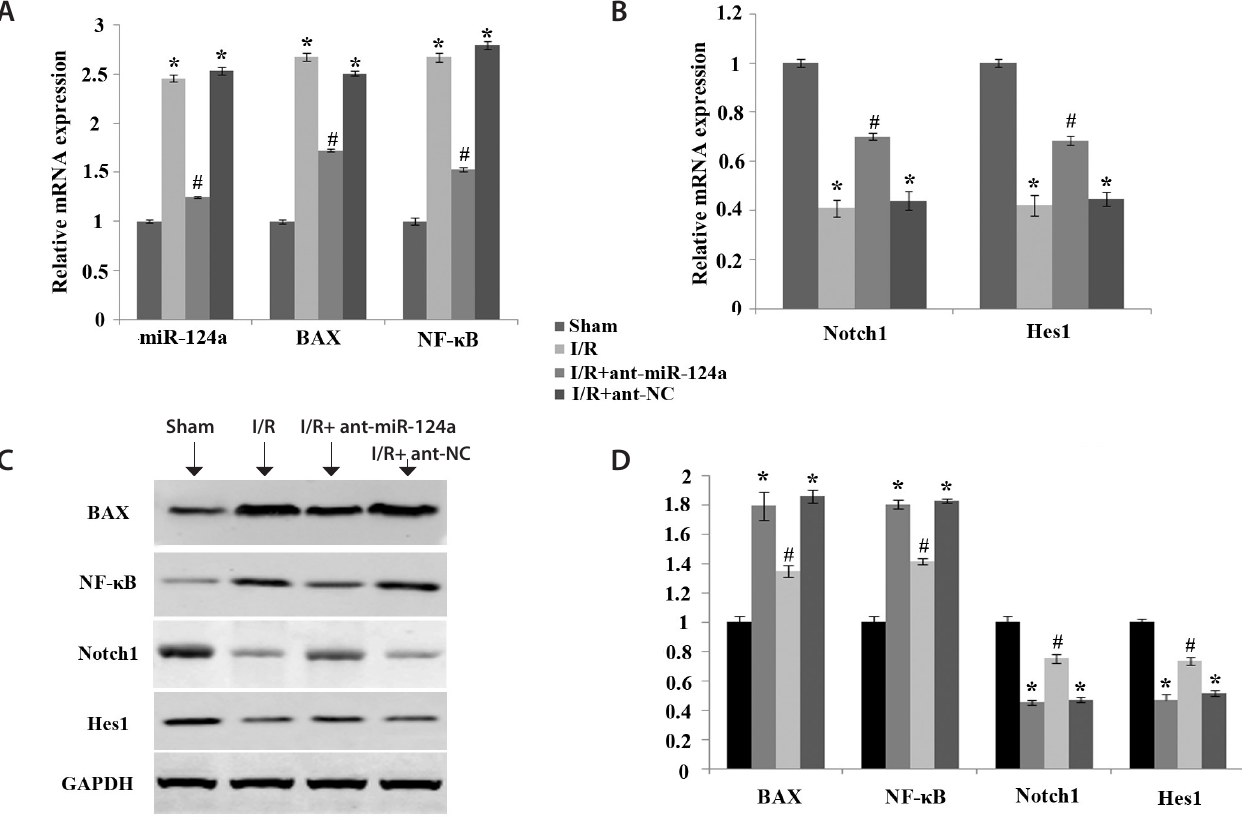
Fig. 4 - Effects of micro ribonucleic acid (miR)-124a on messenger ribonucleic acid (mRNA) and protein expression levels of related factors in the Notch pathway in rat myocardial tissue after ischemia reperfusion (I/R). (A) mRNA expression levels of miR-124a, BAX, and nuclear factor kappa B (NF-κB) in each group. (B) mRNA expression levels of Notch1 and Hes1 in each group. (C) Western blot was used to detect the protein expression levels of BAX, NF-κB, Notch1, and Hes1 in the myocardial tissues of each group. (D) Protein expression levels of BAX, NF-κB, Notch1, and Hes1 in the myocardial tissues of each group. The values are expressed as X±S. Compared with sham group, *P<0.05; compared with I/R group, #P<0.05. ant=antagomir; GAPDH=glyceraldehyde 3-phosphate dehydrogenase; NC=normal